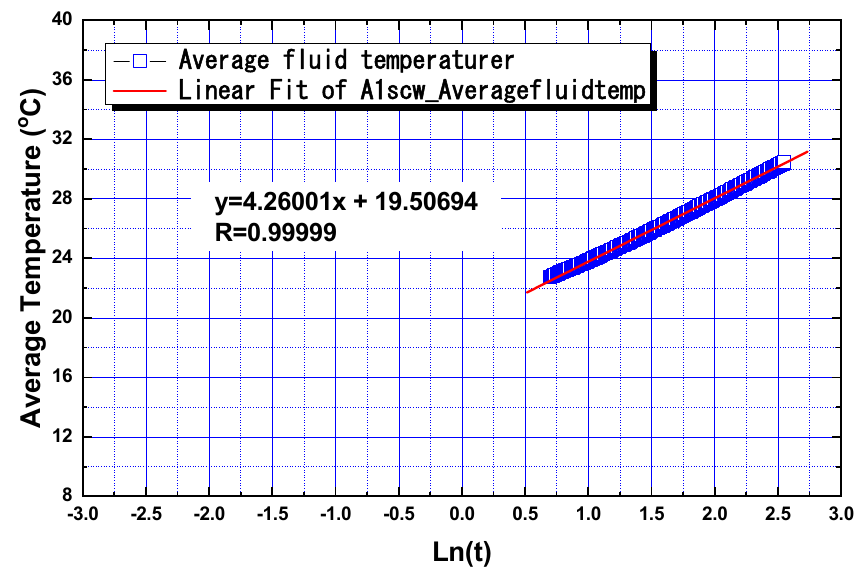
Figure 8. Linearization of the average temperature at the location of the lower return pipe.